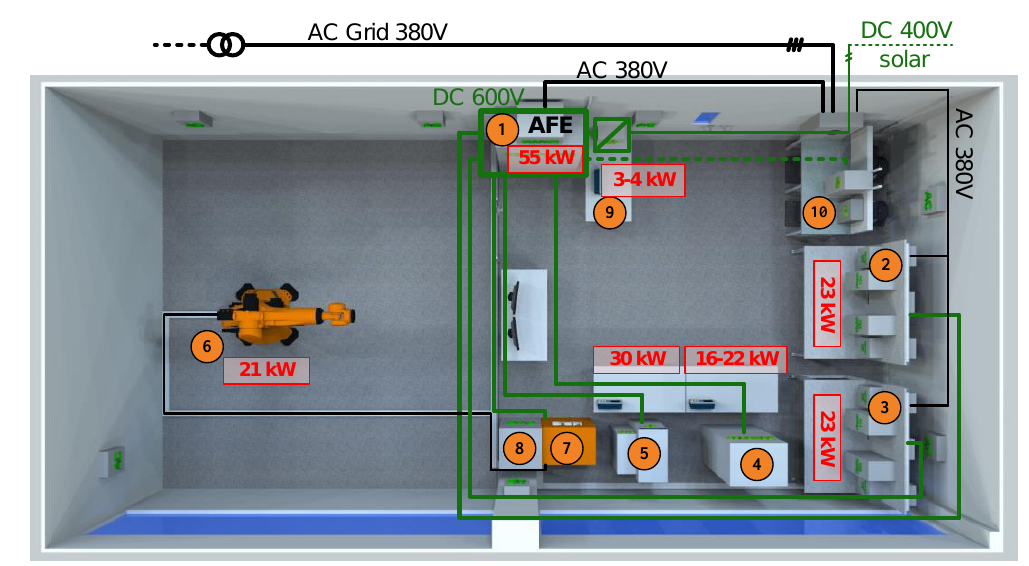
Fig. 5 Experimental verification laboratory hardware testing layout of industrial DC-Grid infrastructure.